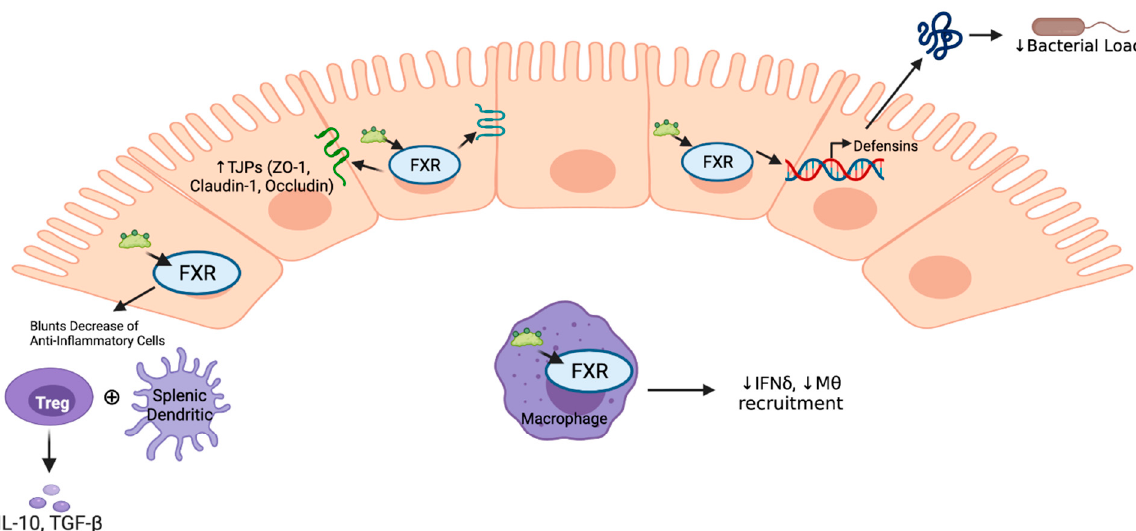
Figure 3. FXR plays numerous roles in maintaining barrier integrity and promoting decreased inflammation. TJP-tight junction proteins; Treg-t regulatory cells; IL-interleukin; ZO- zona occludens; M θ -macrophage (created with BioRen- der.com accessed on 10 October 2021).